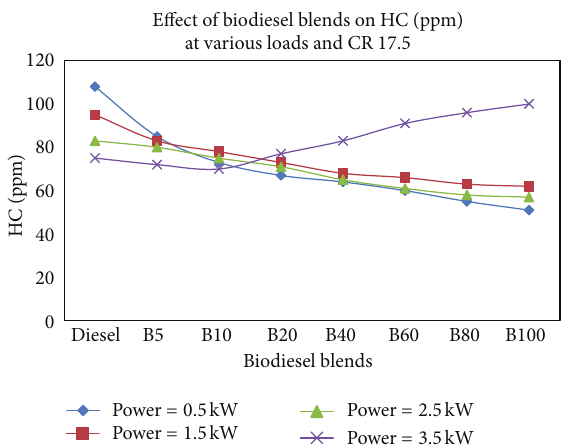
Figure 6: Variation in BSFC for various biodiesel blends at different loads.